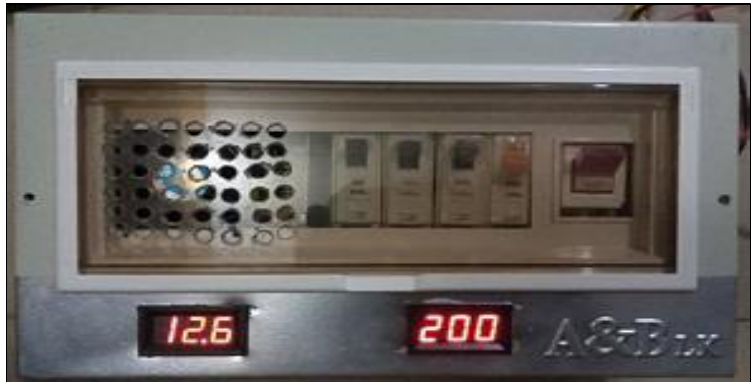
Figure 4: Constructed Hybrid Distribution Board